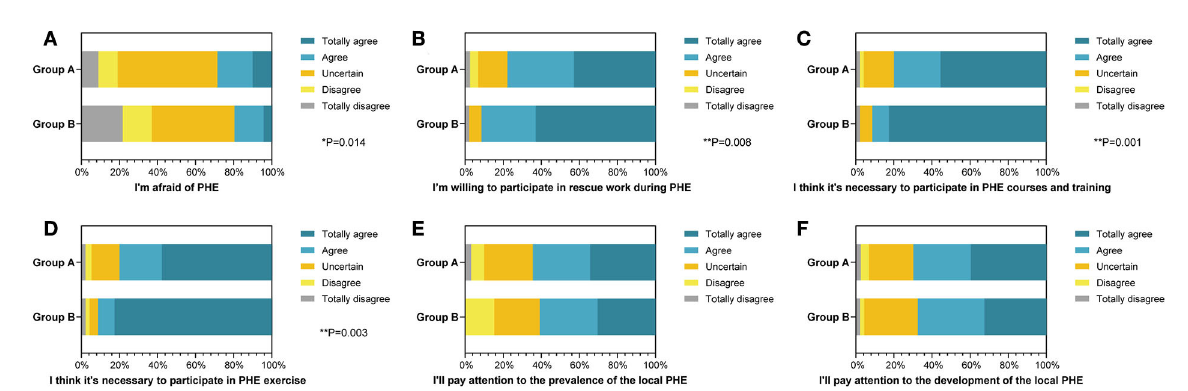
FIGURE1 The percentage stacking histograms of the comparison in the subjective cognition toward public health emergency (PHE) between clinical and preventive medicine students with a 5-point Likert scale. (A) The fear of PHE between clinical and preventive medicine students. (B) The willingness to participate in rescue work during PHE between clinical and preventive medicine students. (C) The thought of the necessity to participate in PHE courses and training between clinical and preventive medicine students. (D) The thought of the necessity to participate in PHE exercise between clinical and preventive medicine students. (E) The attention to the prevalence of the local PHE between clinical and preventive medicine students. (F) The attention to the development of the local PHE between clinical and preventive medicine students. The nonparametric test was applied for the comparison (The number of group A is n1 = 189; the number of group B is n2 = 46).